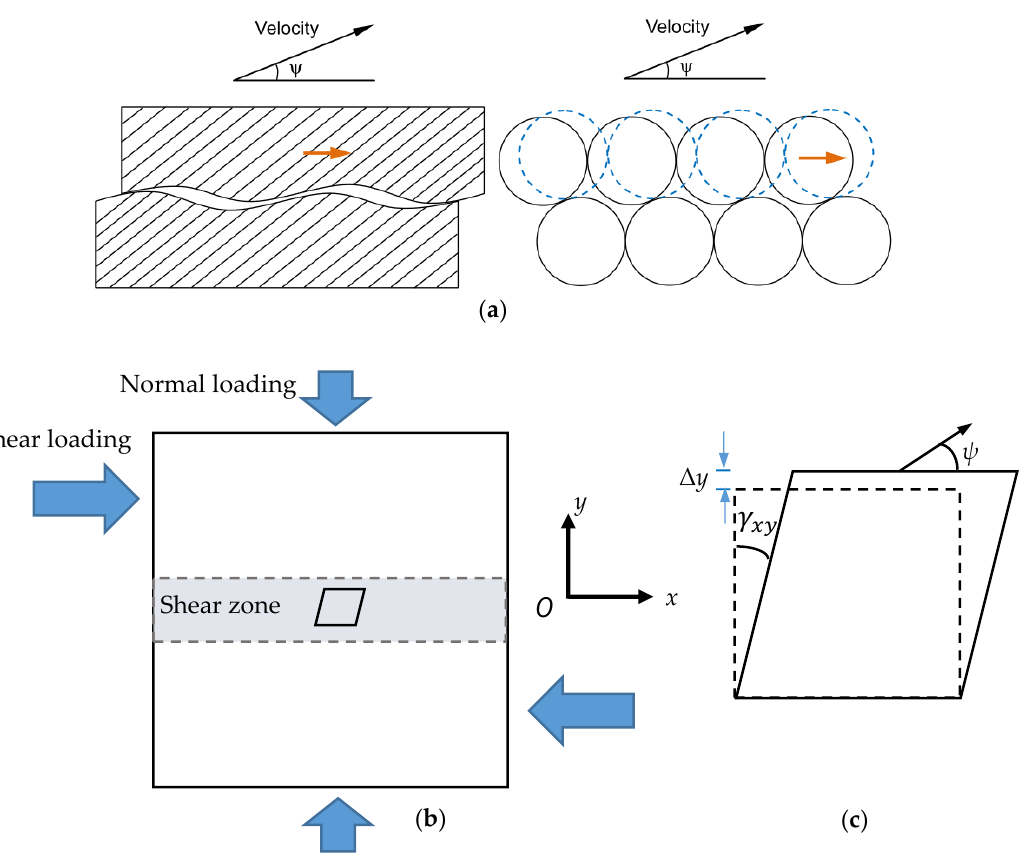
Figure 1. ( a ) A sketch on the physical meaning of dilation associated with sliding along micro-cracks and particles [34,35] (Reprint with permission [35]; (License Number: 4735211037160, 2010, Elsevier). ( b ) A sketch of the direct shear experiment on a cubic sample (with the size of 100 × 100 × 100 mm in this study). ( c ) The physical meaning of shear strain γ and dilation angle ψ with an element from the shear zone.